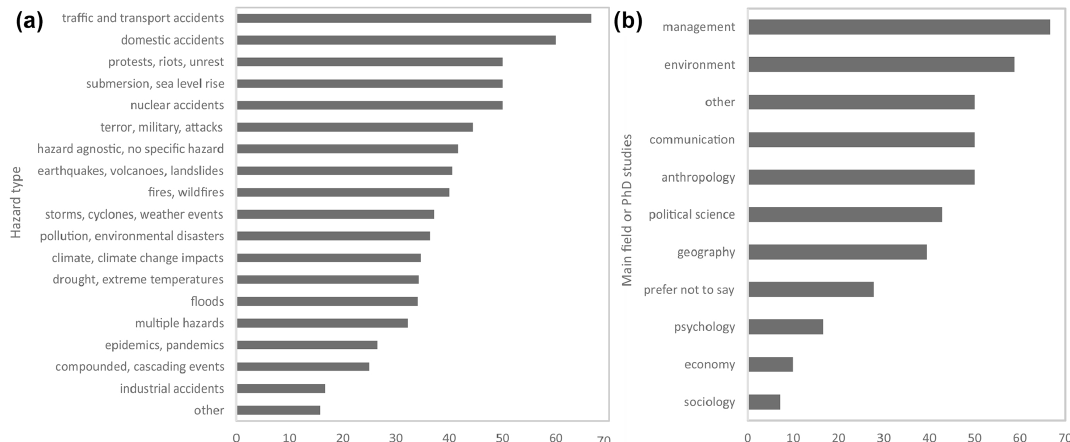
Figure 3. Percent of respondents that did not rely on a theory, according to (a) the hazard they investigated and (b) their field of knowledge.